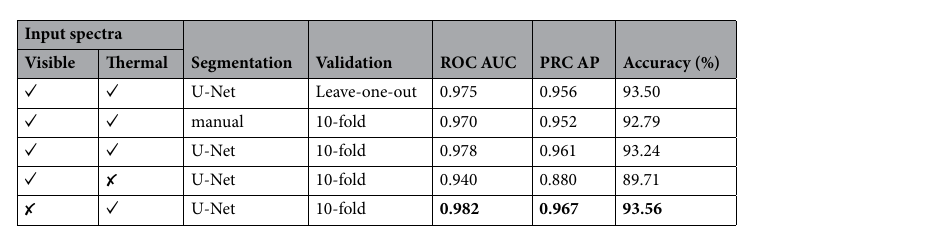
Table 2. Validation results for different types of segmentation and input data. The best values are in